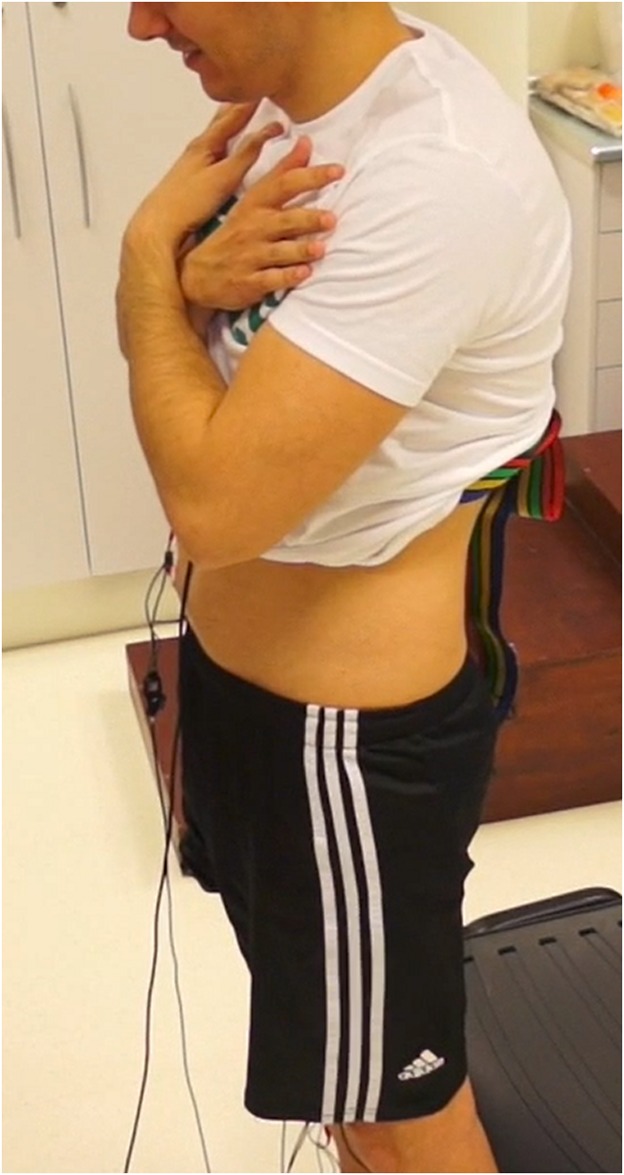
STS starting position.